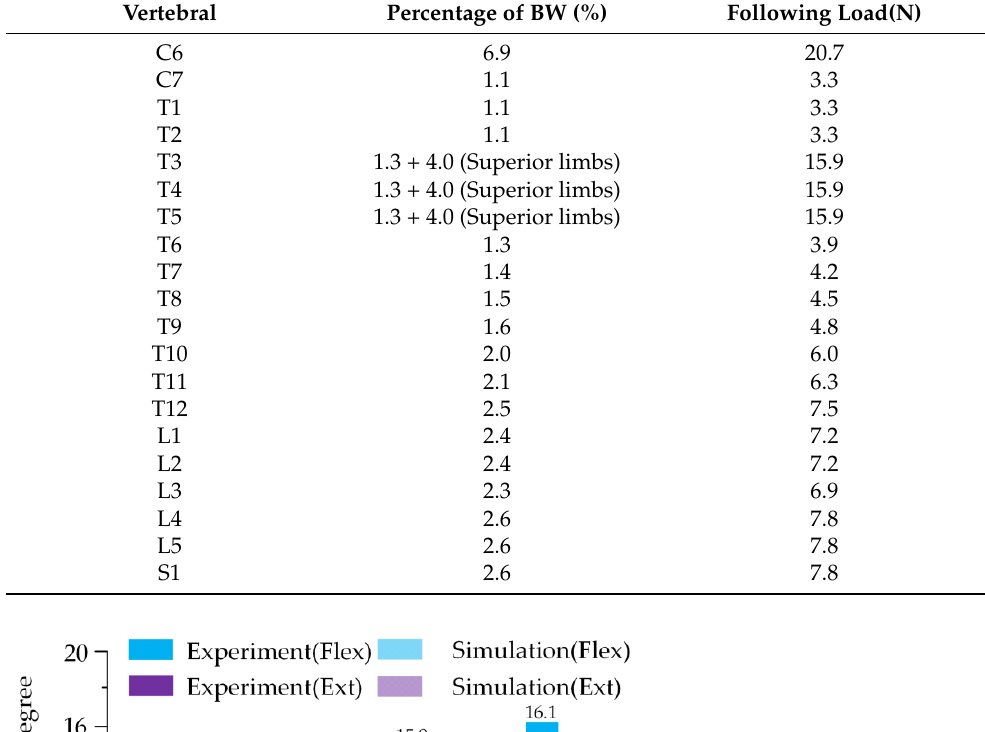
Table 2. Following load magnitude of each segment of C6-S1 [24].